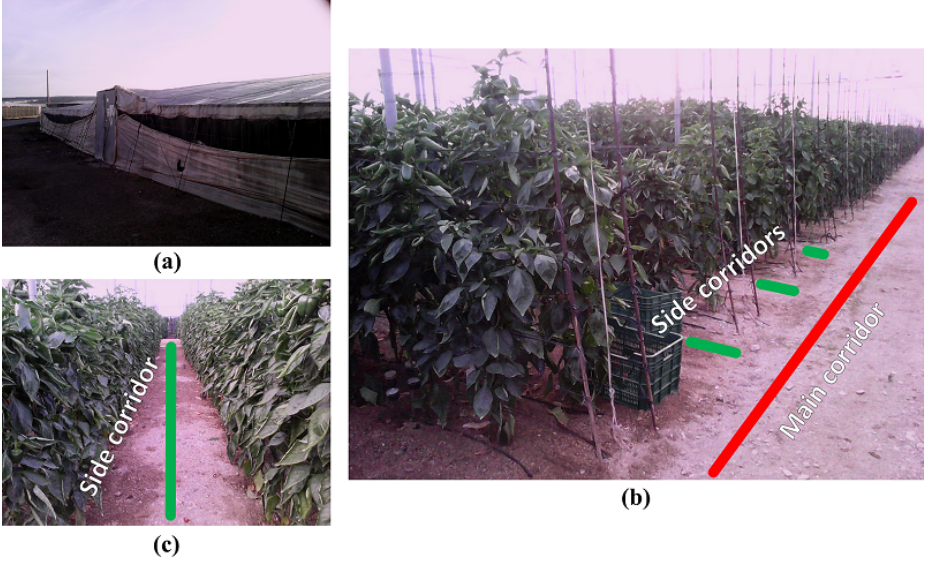
Figure 1. A typical greenhouse of Almería from multiple perspectives: ( a ) Outside; ( b ) Main corridor; and ( c ) Side